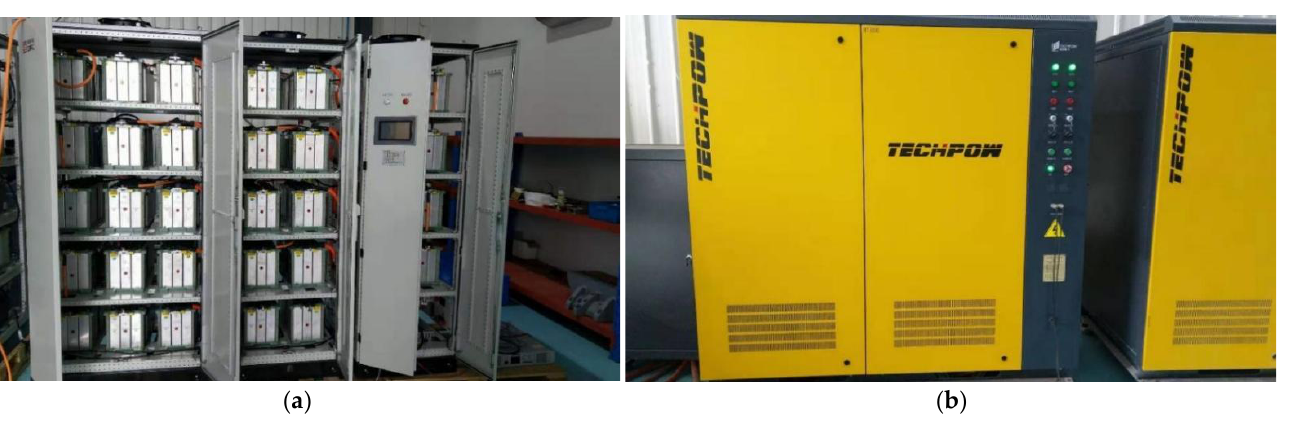
Figure 7. Efficiency test of supercapacitor storage. ( a ) Supercapacitor storage. ( b ) Efficiency test equipment.